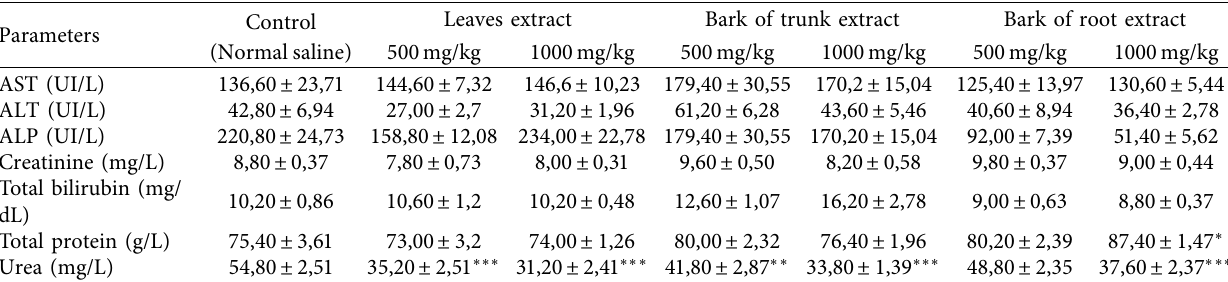
Values are expressed as mean ± standard error of mean (SEM) ( n � 5); ∗ p < 0 . 05, ∗∗ p < 0 . 01, and ∗∗∗ p < 0 . 001; control group versus extract. WBC: white blood cells, RBC: red blood cells, HGB: hemoglobin, HCT: hematocrit, MCV: mean corpuscular volume, MCH: mean corpuscular hemoglobin, and MCHC: mean corpuscular hemoglobin concentration. Table 5: Biochemical parameters for rats after 28-day treatment with hydroethanolic leaf, bark of trunk, and bark of root of P. santalinoides .